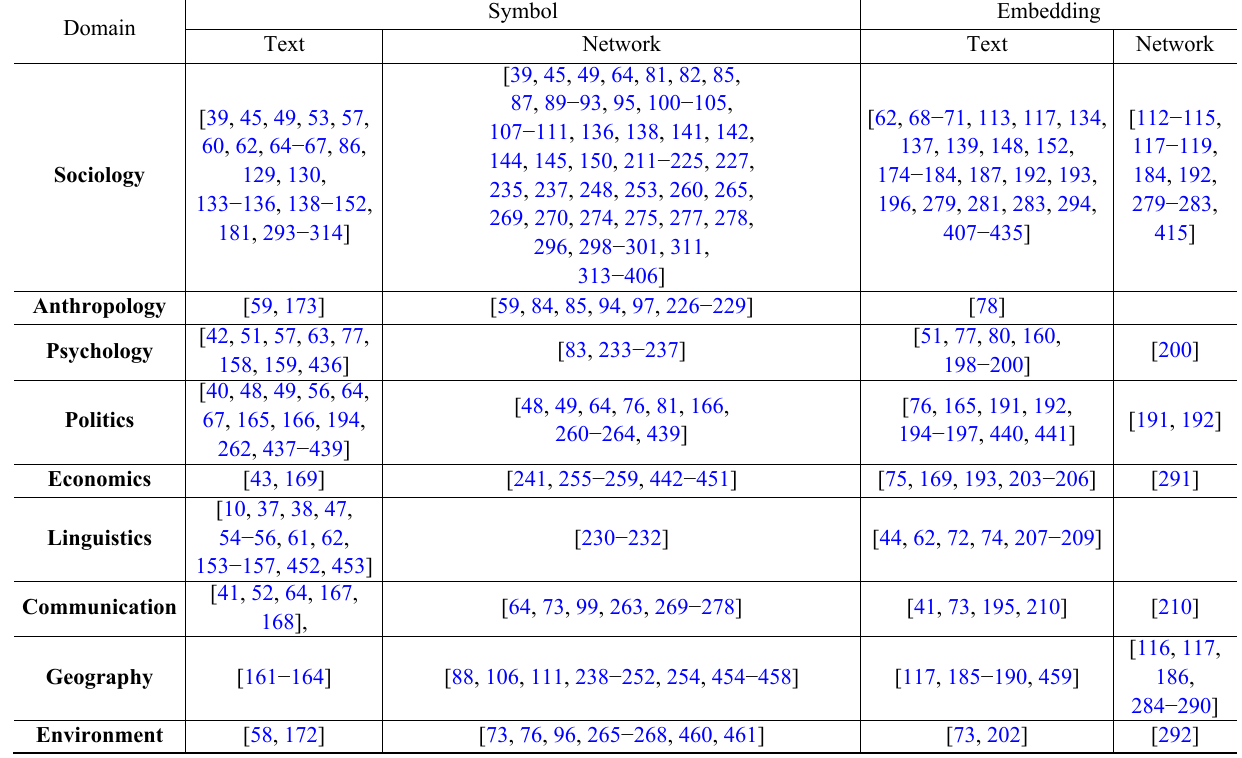
Table A1 Distribution of CSS